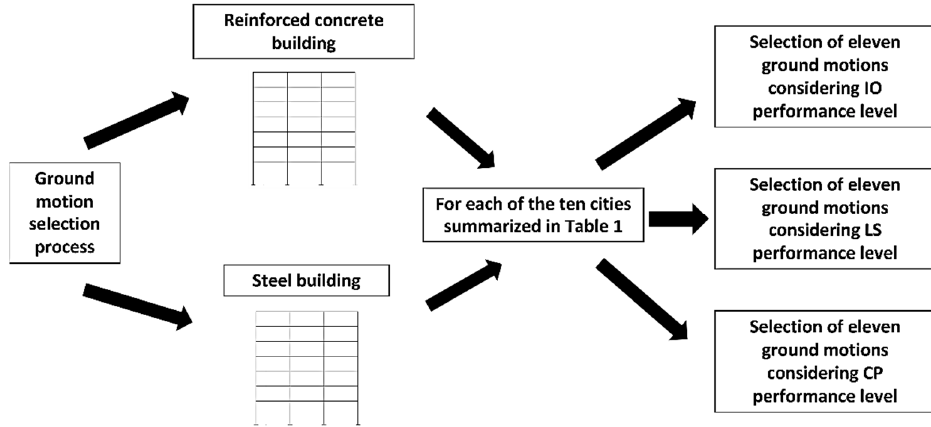
Figure 4. Ground motion selection process.